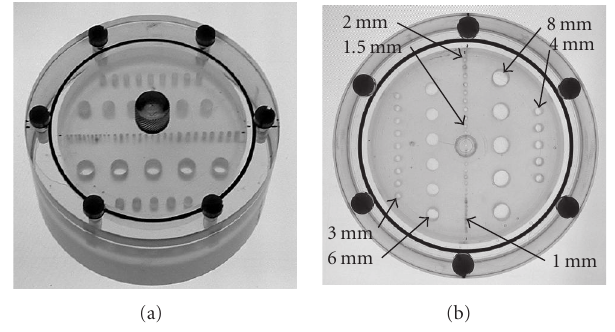
Figure 3: Phantom: a specially treated polycarbonate disk allowed 18 F-FDG solution to flow freely through holes of varying sizes when immersed in a cup of the solution.